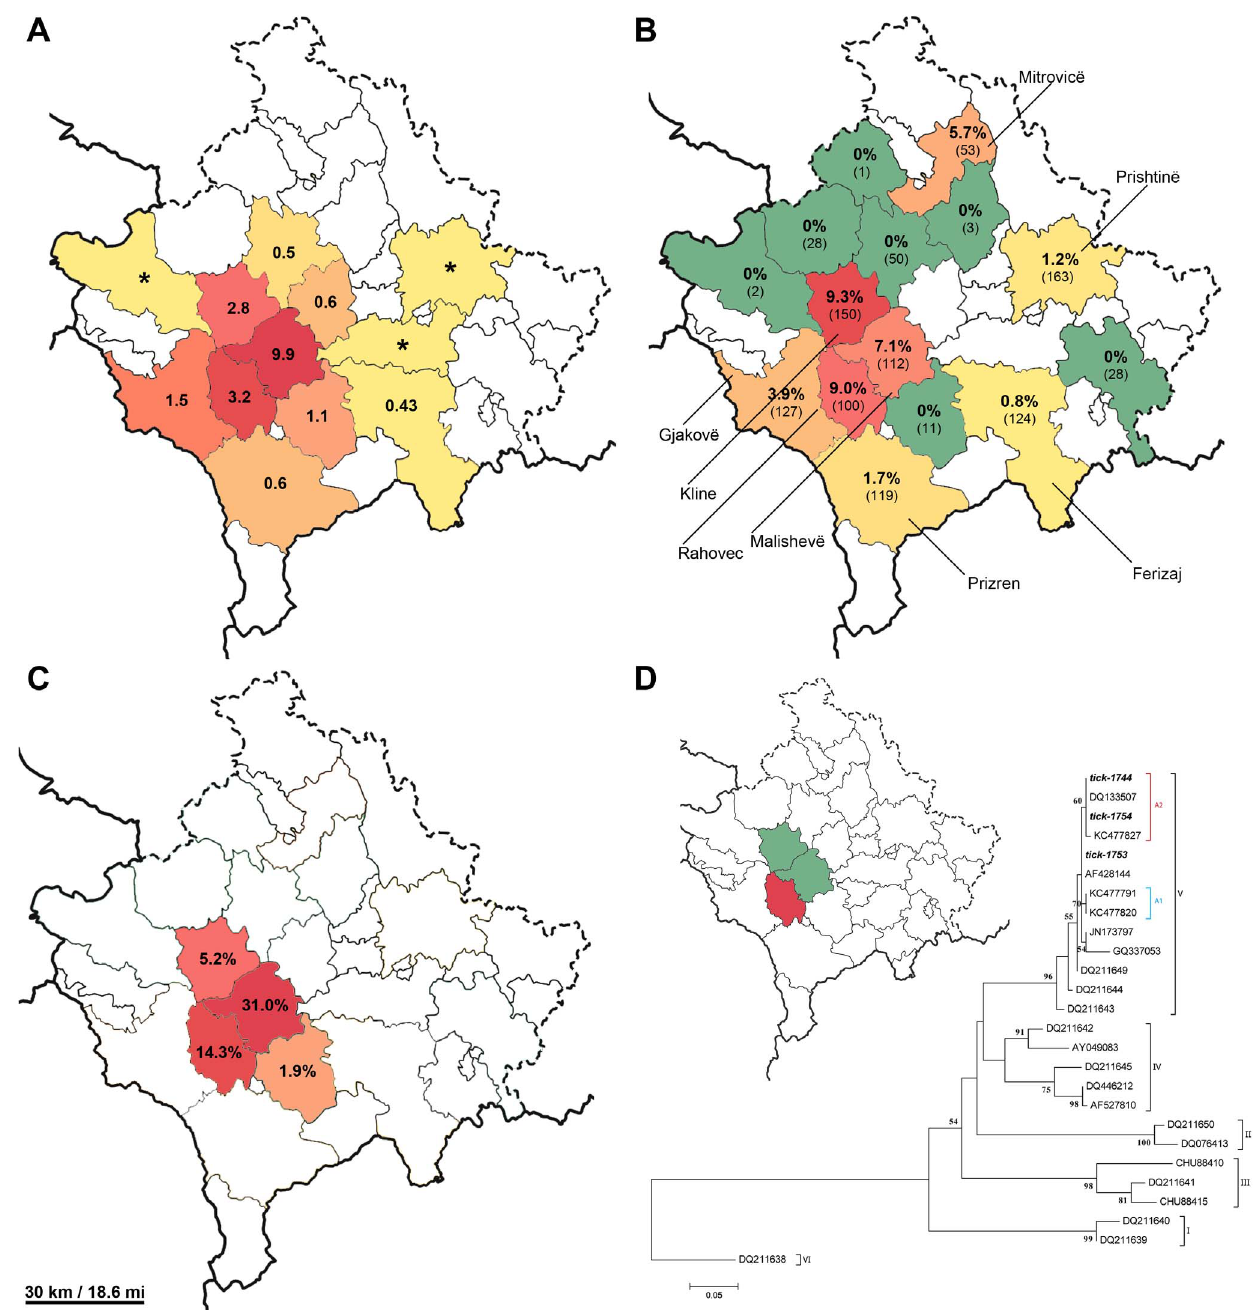
Figure 1. Prevalence of CCHF in Kosovo A. Cumulative incidence (per 100,000) of CCHF (from 1995 to 2013) in each municipality of Kosovo. Asterisk (*) represents a single reported CCHF case. B. Seroprevalence of CCHF in healthy human population in the studied municipalities of Kosovo and the number of tested sera in each municipality (in brackets), C. CCHF seroprevalence in cows in the studied municipalities of Kosovo, D. maximum likelihood phylogenetic analysis (with 1000 bootstrap) of partial (260 bp) CCHFV S segment nucleotide sequences. The map shows the municipalities where ticks were collected (green and red) and the municipality (red) of the positive ticks that were included in the study for CCHFV sequencing. Designations A1 and A3 represent Kosovo CCHFV sub-lineages described by Fajs et al. [27].